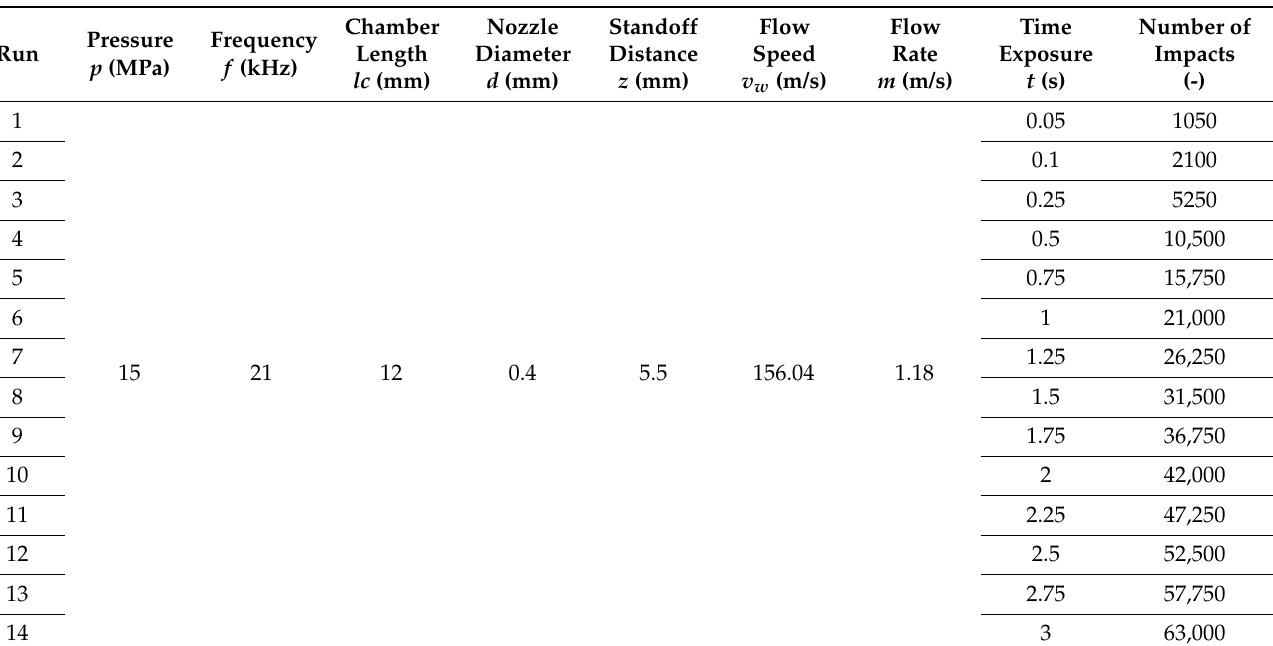
Table 4. Technological conditions of the